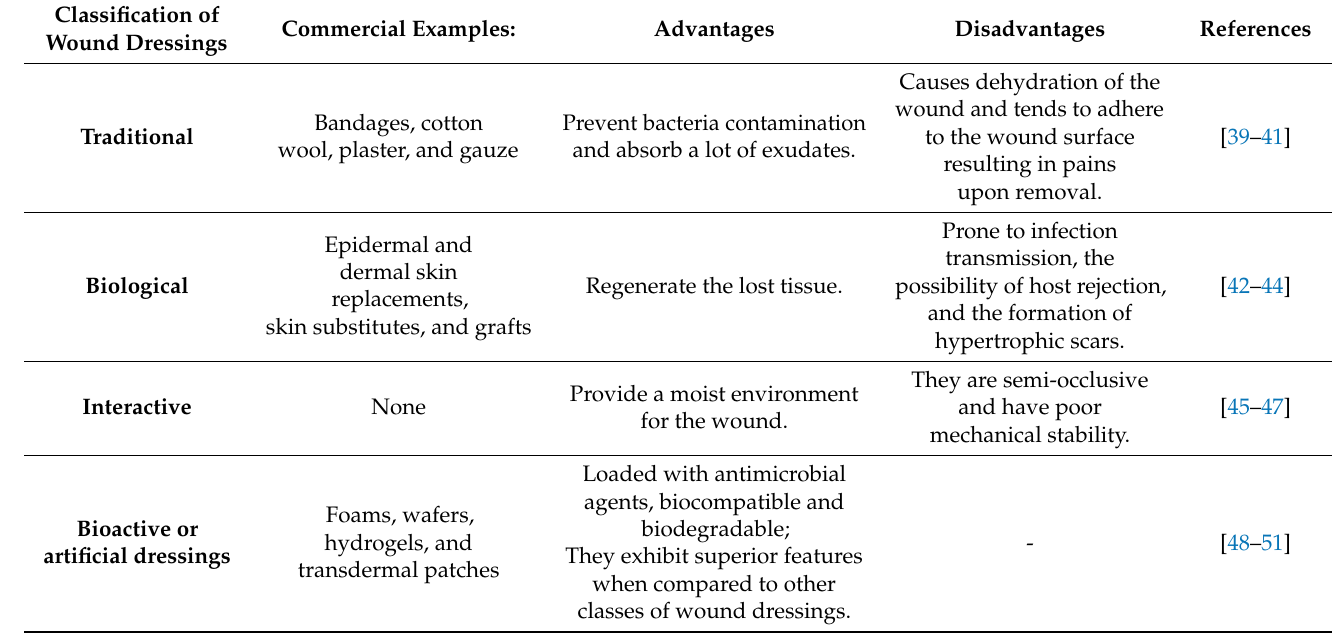
Table 2. Classes of wound